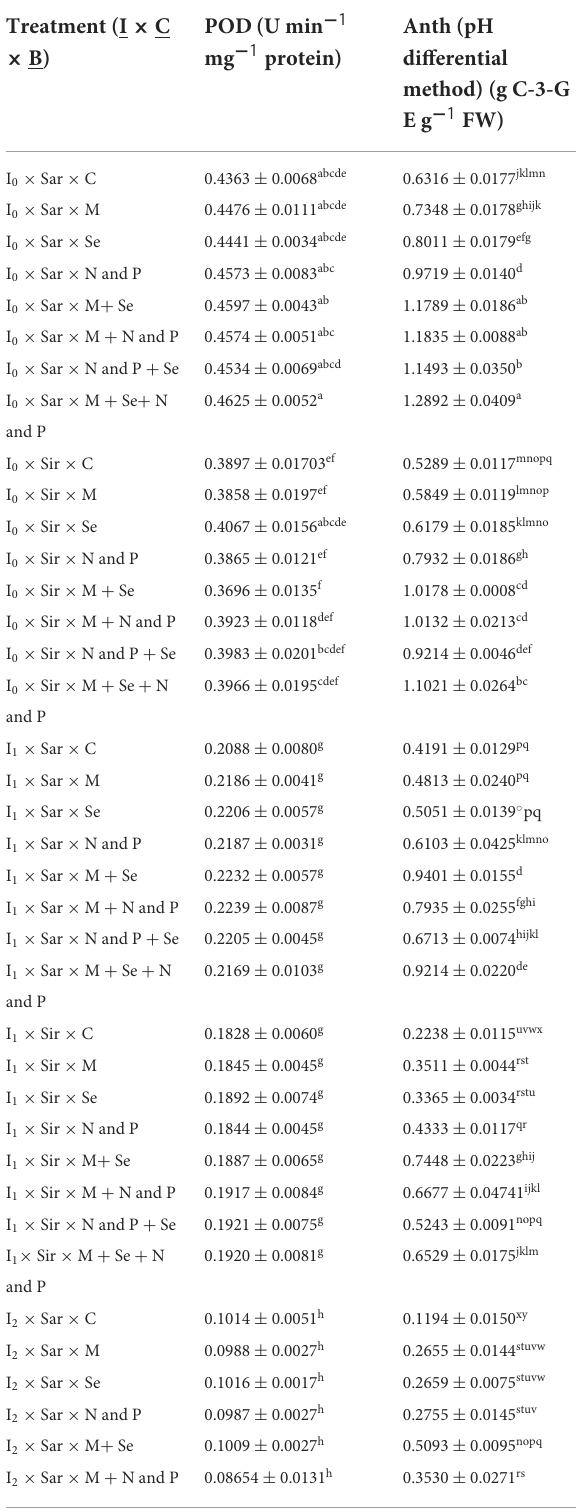
TABLE 6 Mean comparison of the interaction of Irrigation levels × Cultivars × Bio-fertilizers on POD activity and Anth content of wheat in